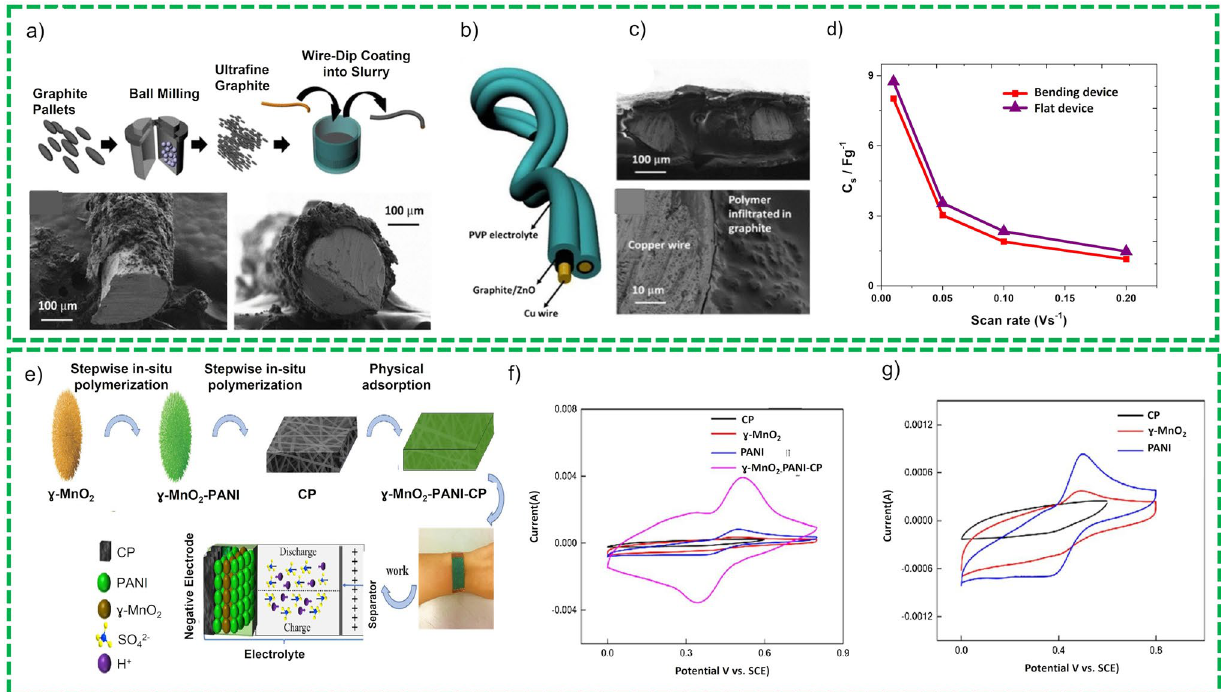
Fig. 10 a Schematic representation of fabrication of the wire-based electrode, b pictorial representation of two parallel electrode configura- tion, c SEM image shows composite (graphite/ZnO) electrodes and gel-polymer electrolyte sandwiched between them, d bending stability tests. Reprinted with permission from Ref. [77]. e Graphical flow diagram for MnO 2 /PANI-based electrode fabrications, f CF ration of carbon paper and pore size distribution, g bending stability test of the electrode. Reprinted with permission from Ref.